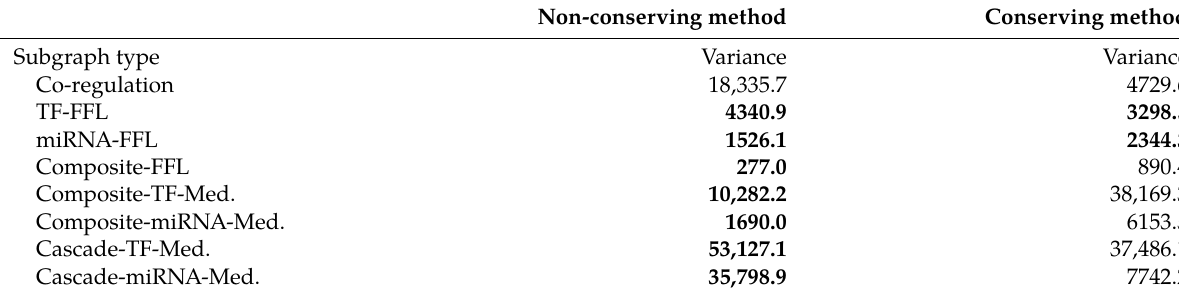
Table 4: Variance of count distributions of subgraphs in randomized networks for GBM network. Non-conserving